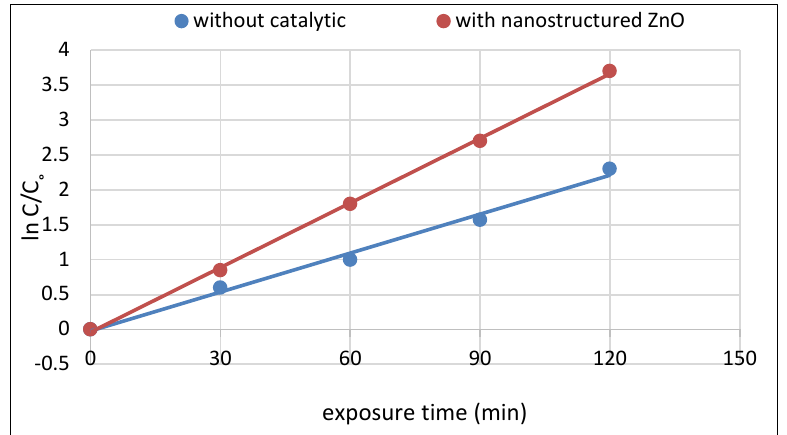
Fig. 8: Determination the pseudo-first-order kinetic rate constants for blank MB solution and with nanostructured